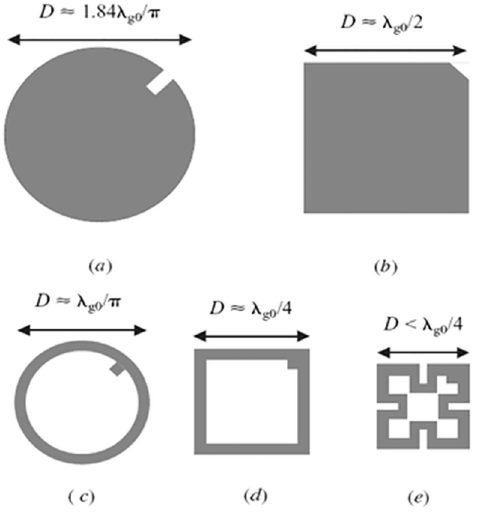
Fig 3. Some microstrip dual-mode resonators (a) Circular disk (b) Square patch (c) Circular ring (d) Square loop (e) Meander loop.